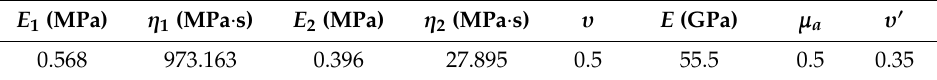
Table 3. Macro parameters for asphalt mastic and